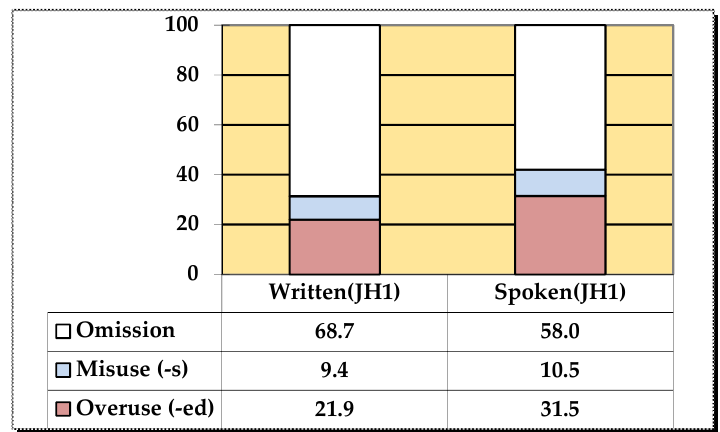
Figure 4. Overuse of regular past − ed in irregular past forms in obligatory affirmative with and without VP − adverb contexts (see Table 6) (%).